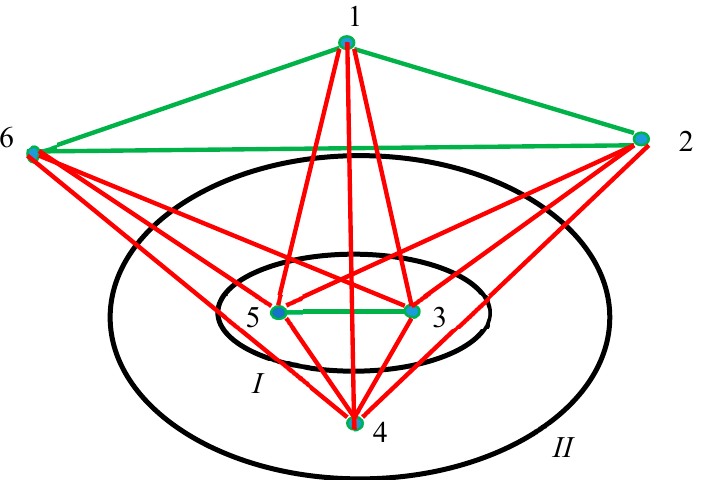
Figure 6. The Jordan curve “ I ” is located within the Jordan curve “ II ”, thus dividing the plane into three regions. Red edges connect points located in different regions; green edges connect points located in the same region. The triangle “126” is green; triangles “456” and “234” are